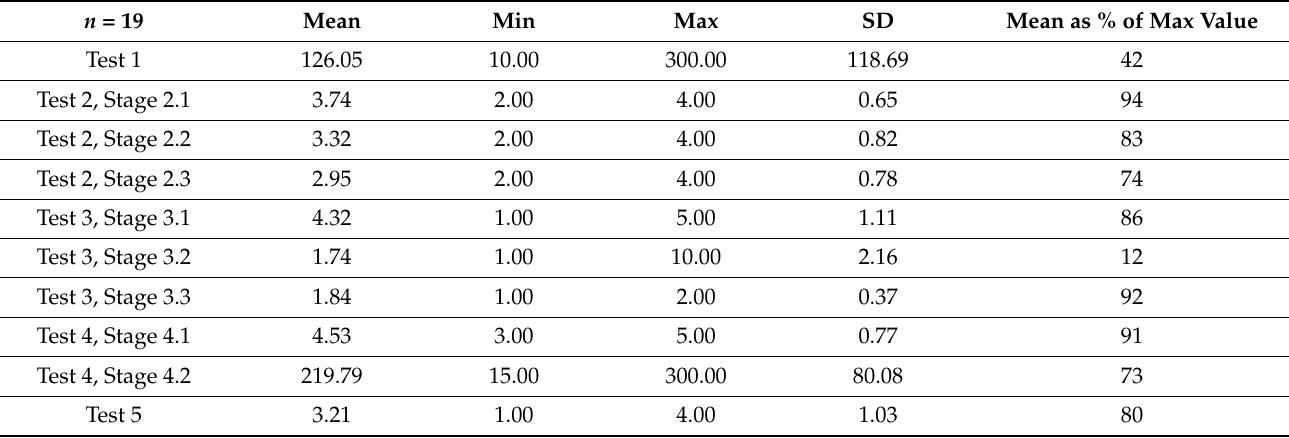
Table 3. Mean, minimum and maximum values and standard deviation (SD) for the subsequent tests and their